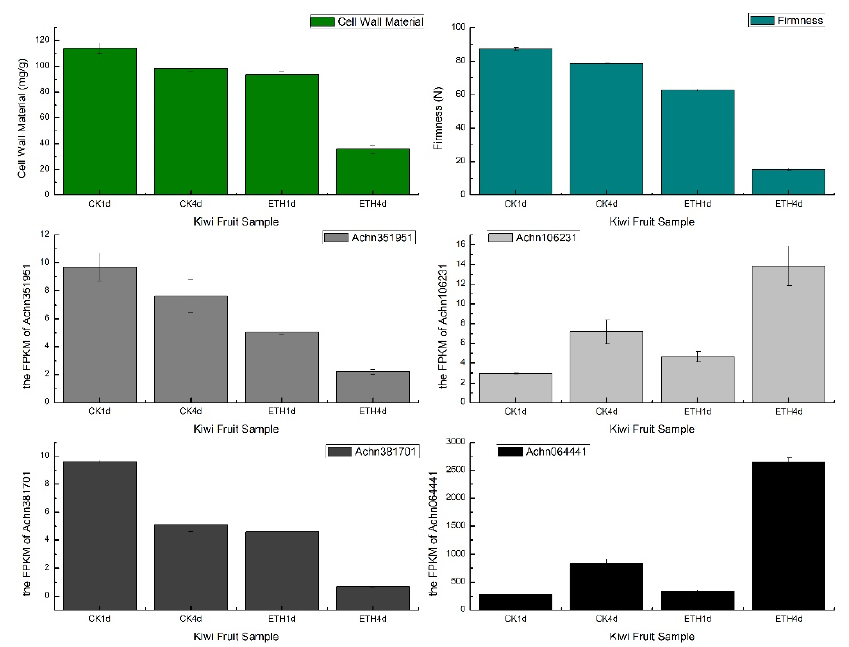
Figure 7. The cell wall material content (mg/g), firmness (N) and FPKM value of four new candidate genes ( Achn351951 , Achn106231 , Achn381701 and Achn064441 ) detected by C-CorA in four groups of kiwi fruit.